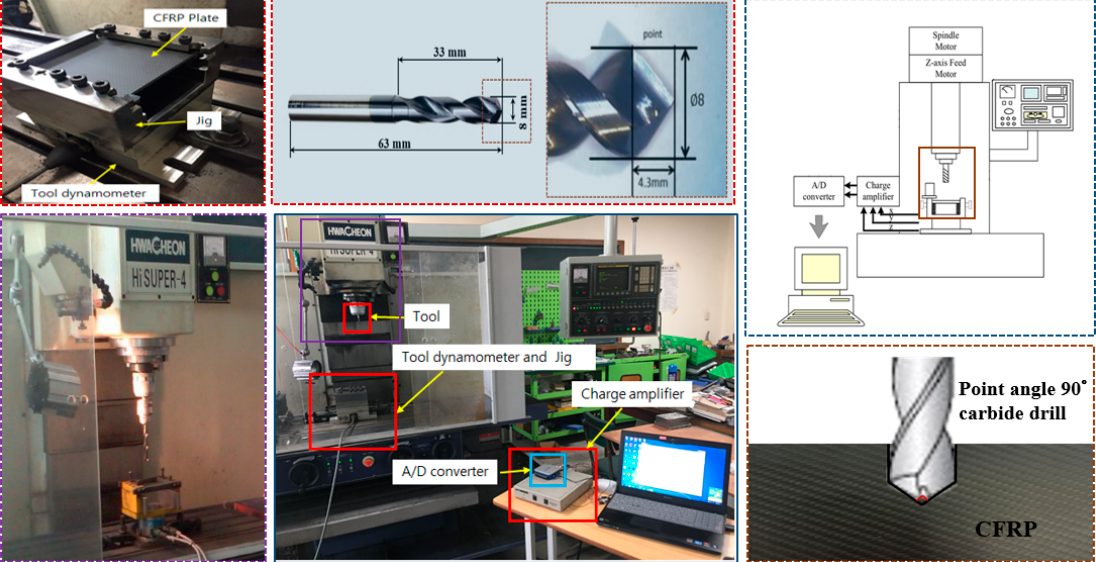
Figure 2. Schematic of experimental setup for drilling.